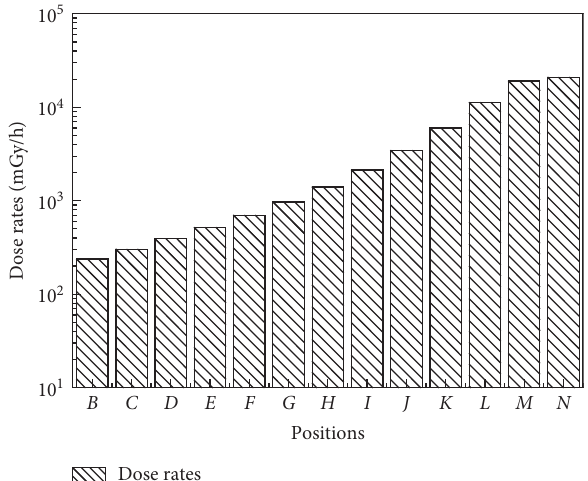
Figure 3: The dose rates from one spent fuel element ( Dpi � 30cm, 5m pipeline, no shielding).